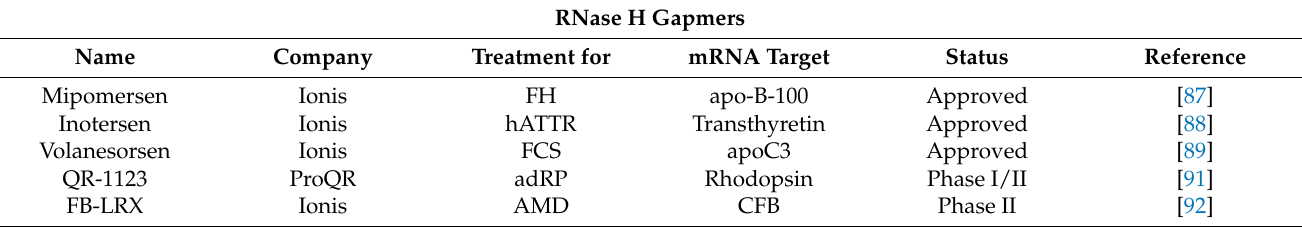
Table 1. RNase H gapmer AONs approved or in clinical